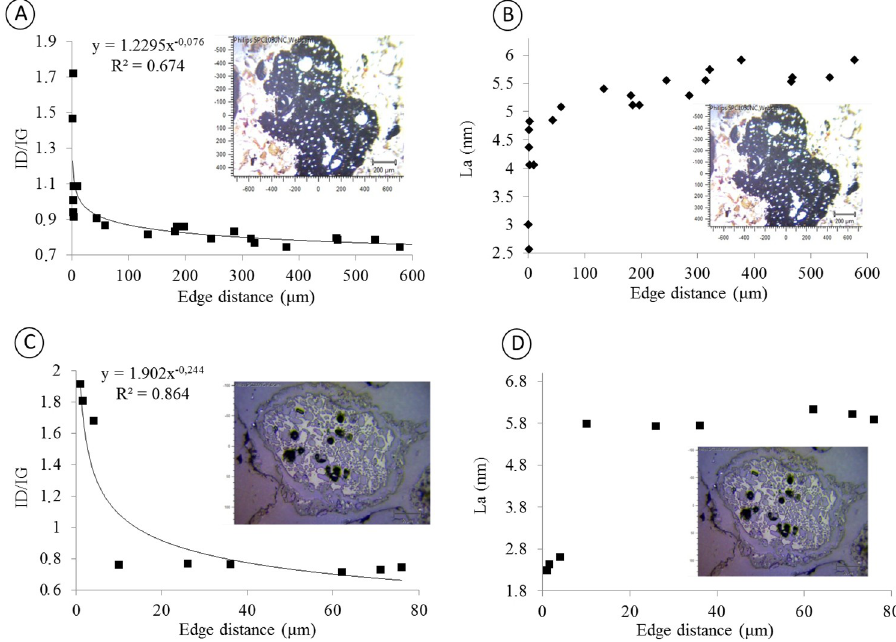
Fig 8. Structural disorder and size of the crystal from the periphery towards the center; A and B, ID/IG and La of charcoal at 1.5 mm; C and D, ID/IG and La of charcoal at 600 μ